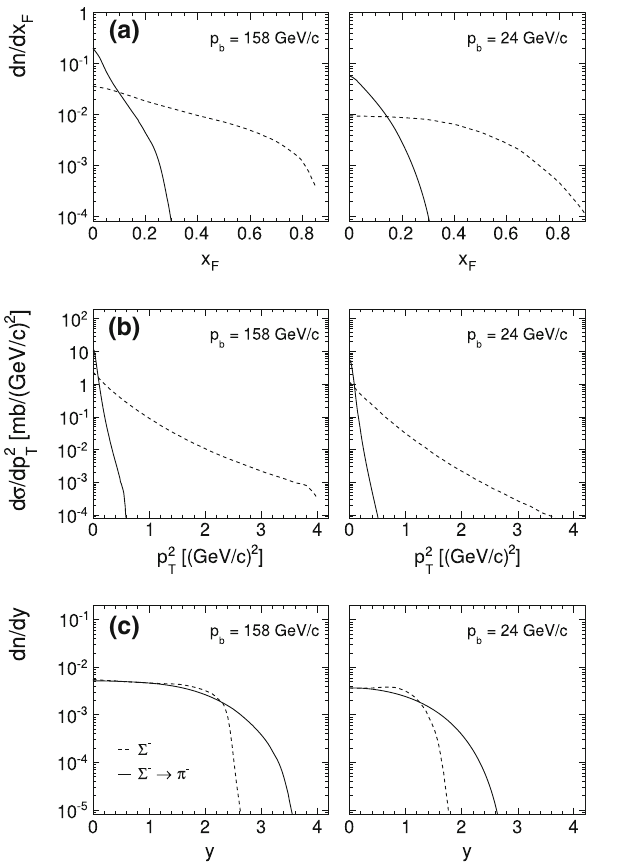
Fig. 22 a dn / dx F as a function of x F , b d σ/ dp 2 and c dn / dy as a function of rapidity for p beam = 158 and 24 GeV/c. The full lines correspond to the π − yields, the broken lines to the parent Σ −